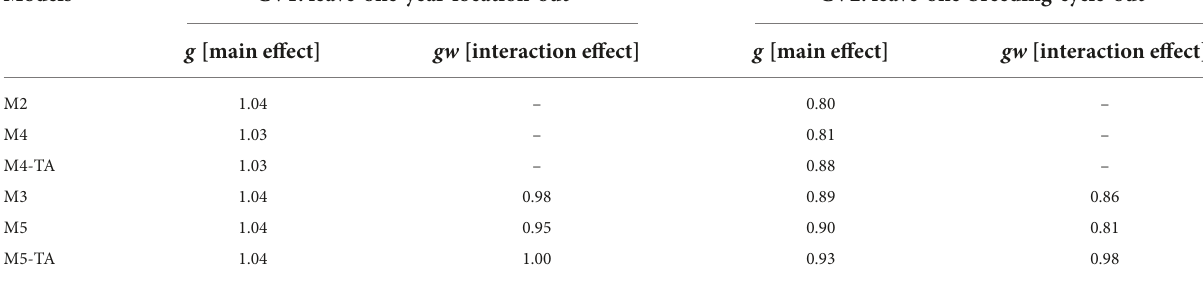
TABLE 8 Slope of regression ( b w , p ) of estimated genetic values with whole information on genetic values with partial information for protein content in leave-one-year-location-out and leave-one-breeding-cycle-out cross-validations.